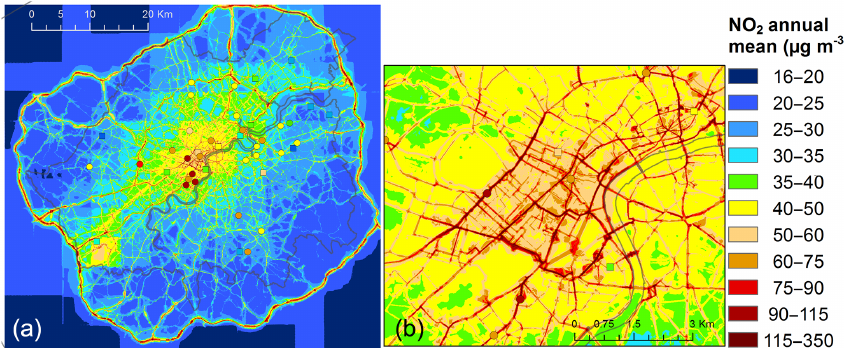
Figure 5. NO 2 annual average concentrations from the coupled model for the whole of Greater London (a) and an area of central London (b) , with monitoring data overlaid – round symbols for near-road sites and square symbols for background sites.